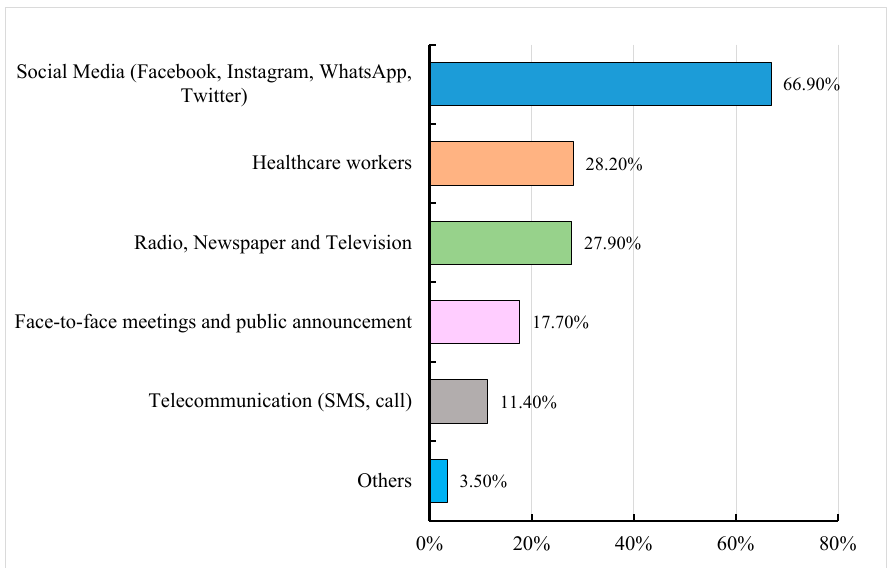
Figure 3. Bar graph representing the preferred platform for receiving information on COVID-19 vaccine and vaccination. Total number of responses: 3105